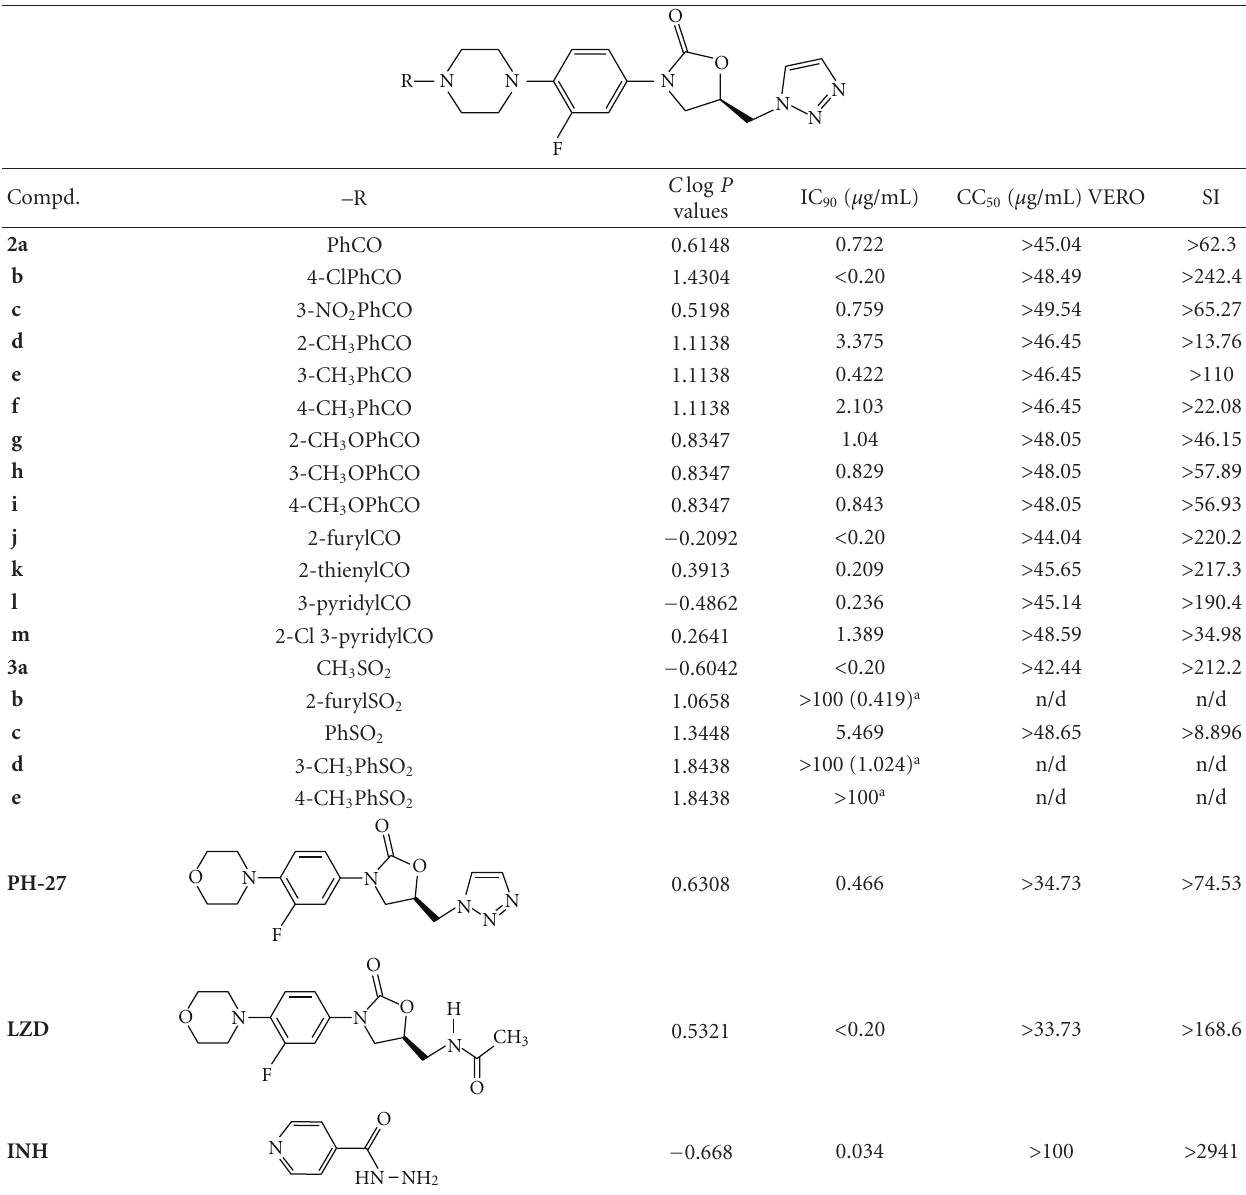
Table 2: In vitro antimycobacterium activity of 4N-arylcarbonyl- and 4N-arylsulfonyl-piperazinyl oxazolidinones against M. tuberculosis